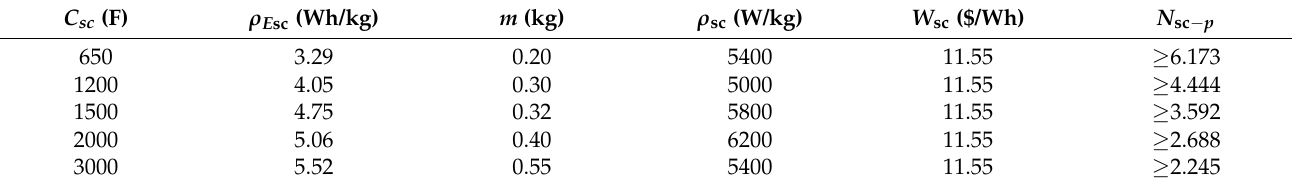
Table 5. The parallel range under different supercapacitors’ capacities.